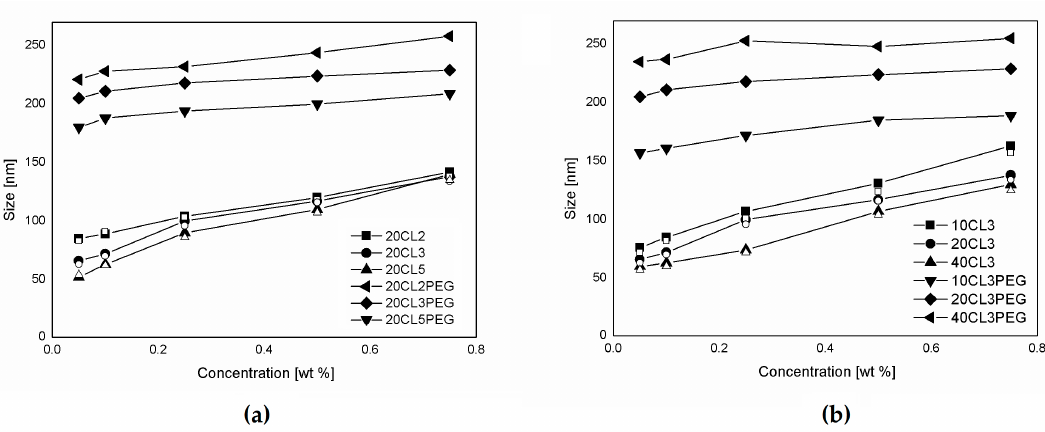
Figure 3. NPs produced via nanoprecipitation with different polymer samples as a function of the